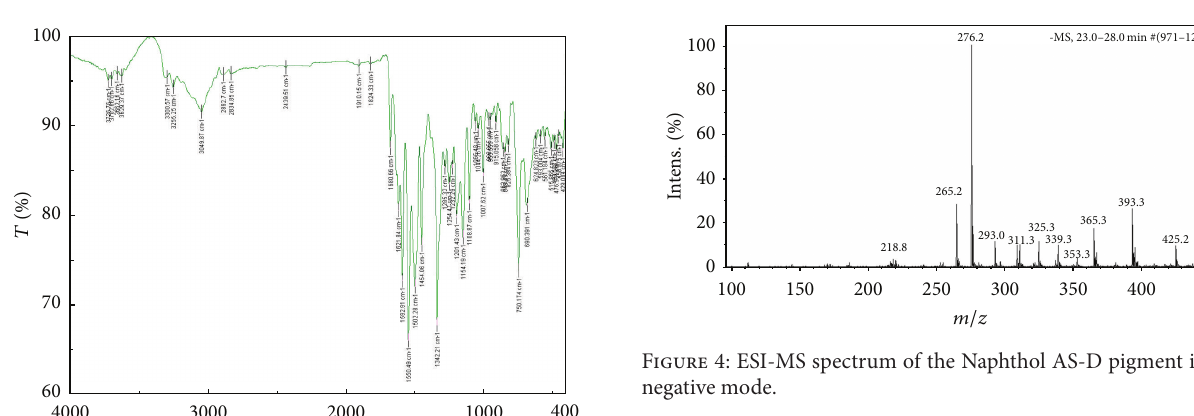
concentrations it was possible to obtain MS 2 spectra with the used ESI source.